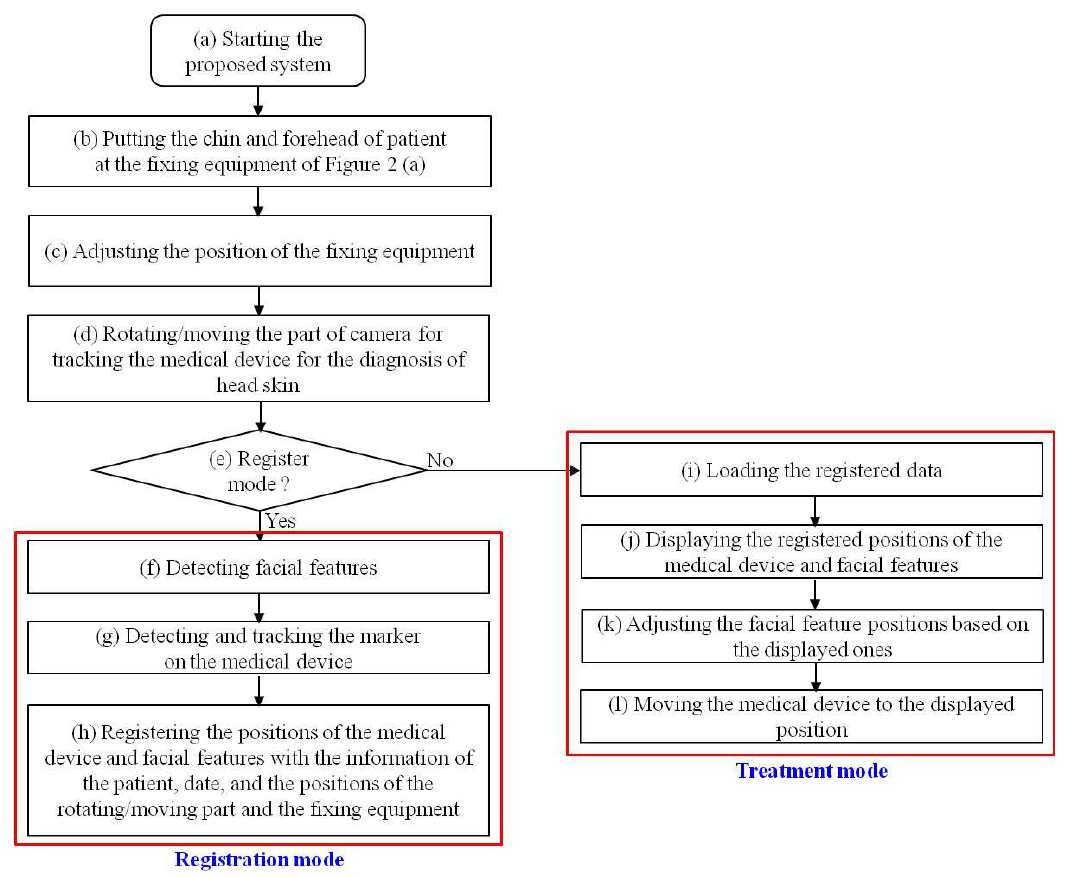
Figure 3. Overall procedure of the proposed method.